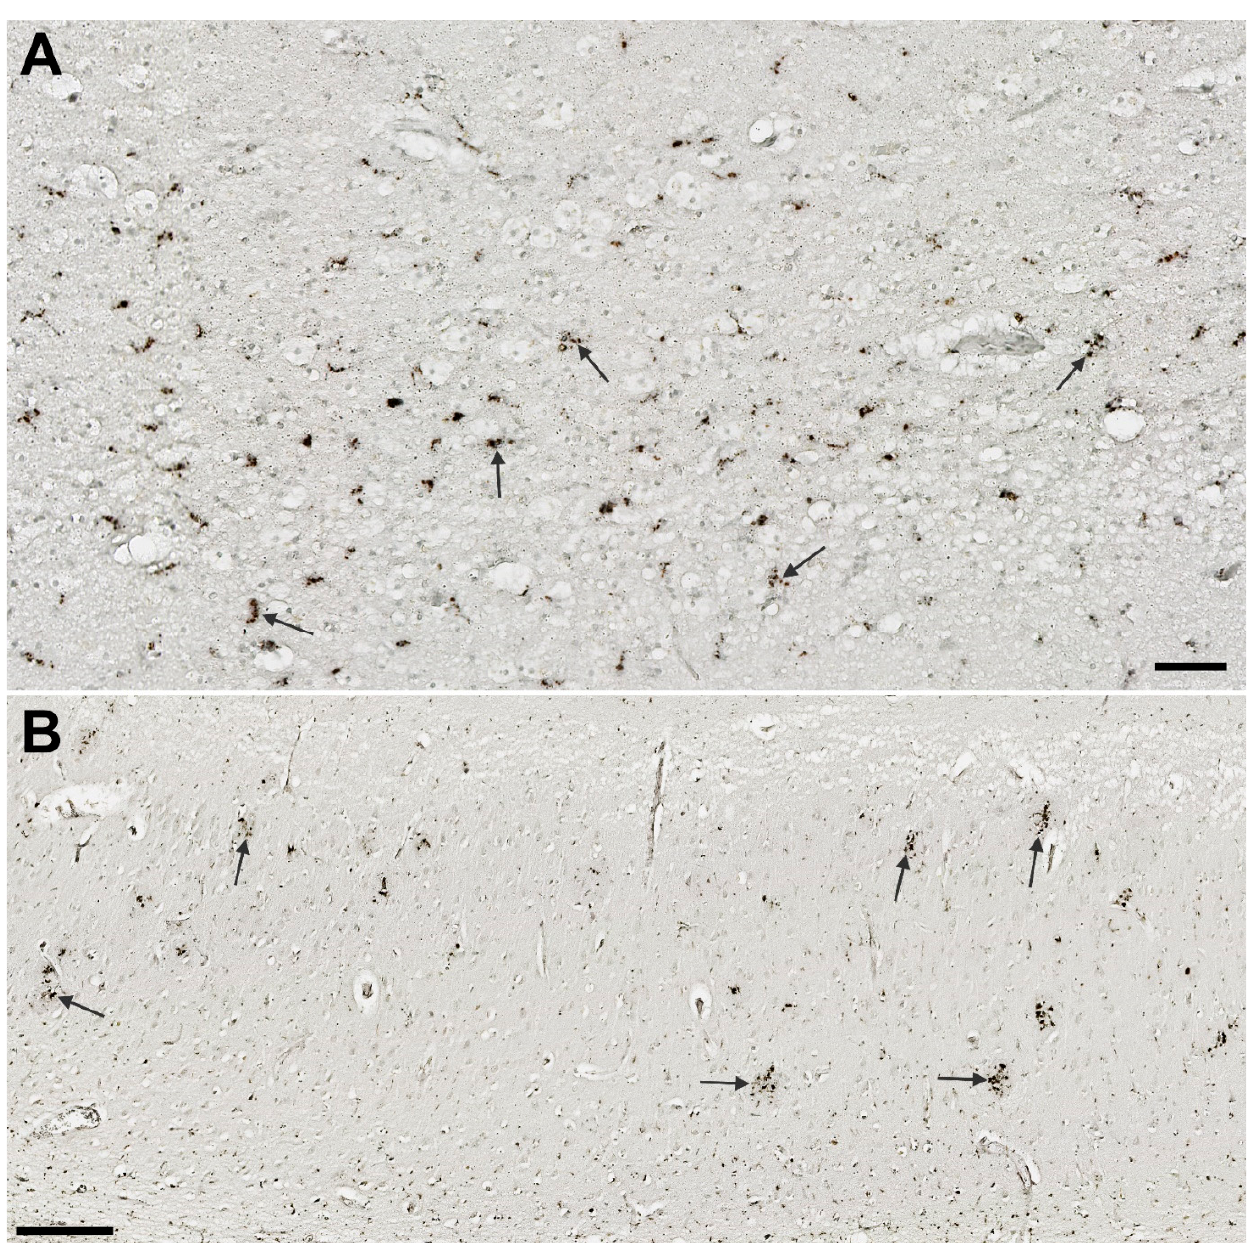
Figure 7. CD68 immunoreactivity of microglia. ( A ) Typical punctiform staining of CD68-labeled activated microglial cells (arrows) in a healthy control in the subiculum. ( B ) Clusters of CD68- expressing microglial cells (arrows) in the CA1 field in AD. Scale bars: A = 50 μ m, B = 250 μ m.